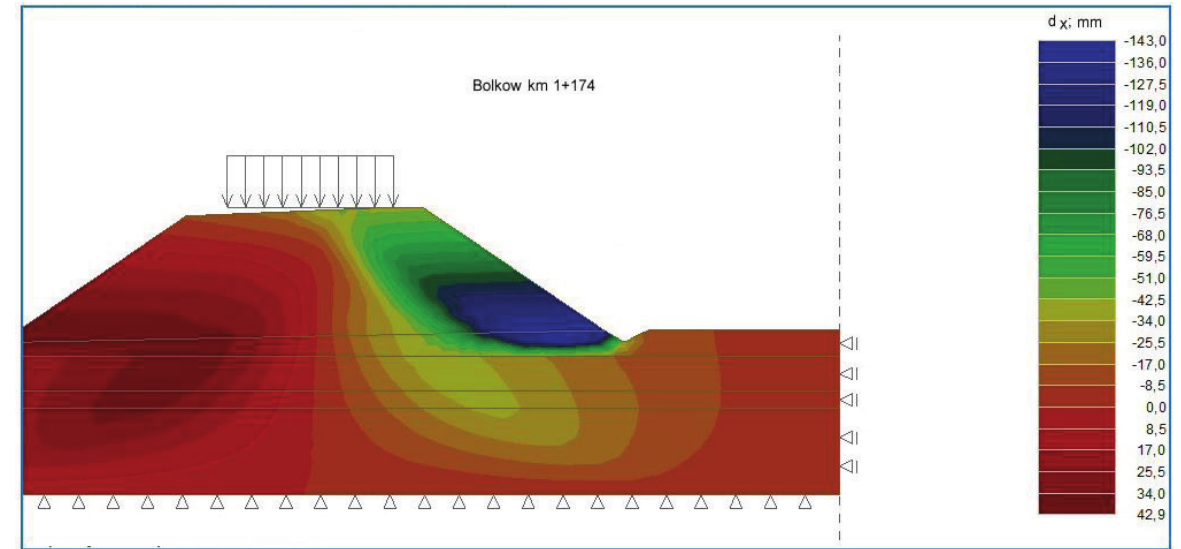
Figure 7. Potential mechanism of the loss of stability – green-blue block in the right slope Figure 7: Potential mechanism of the loss of stability – green-blue block in the right